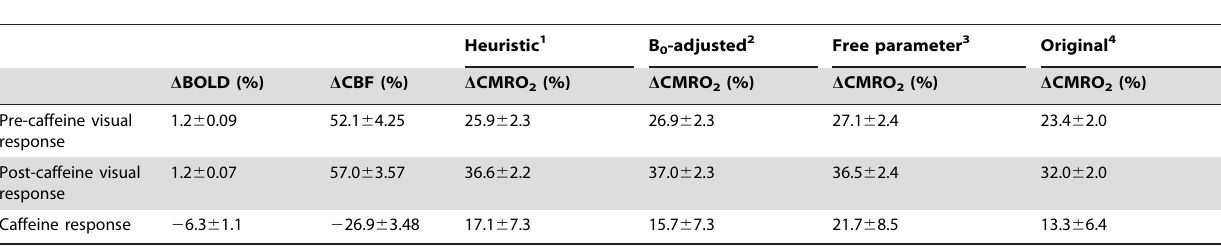
Table 3. Comparing D CMRO 2 calculations by different models using the calibrated-BOLD approach applied to pre- and post- caffeine